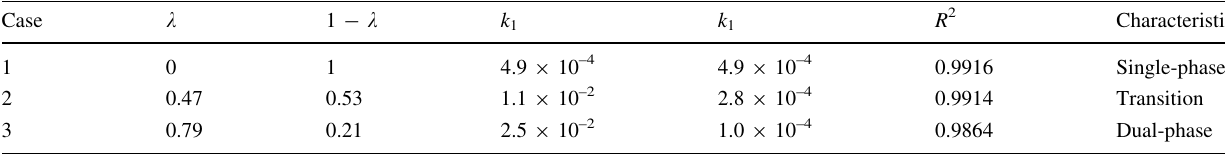
Table 2 Fitting results using Eq.